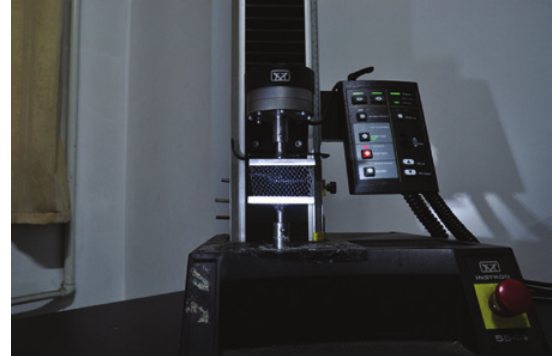
Figure 1 Schematic of honeycombs with hexagonal microstructure.